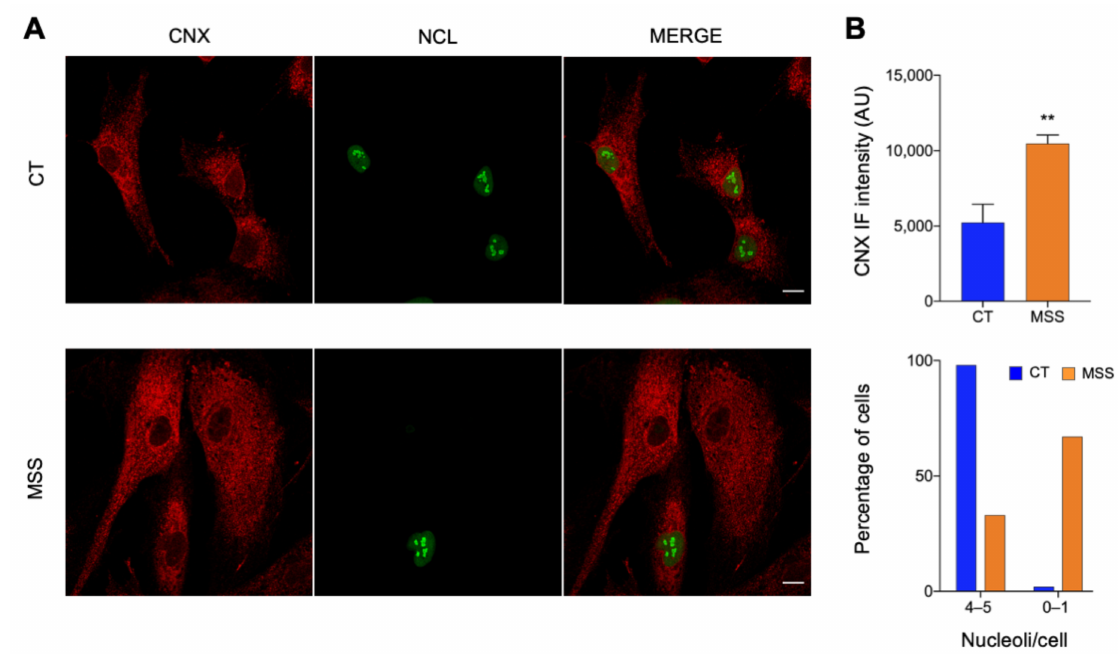
Figure 5. Fluorescence microscopy of representative DE proteins. ( A ) HF-CT (CT) and HF-MSS (MSS) were plated on glass coverslips, fixed in PFA 4%, and processed for immunofluorescence. Confocal images of cells stained for CNX (red) and NCL (green) are shown. The merge of green and red channels is shown in the third panel. Scale bar: 20 µ m. ( B ) Quantification of total CNX staining and the number of NCL-positive nucleoli/cell of the experiment shown in A. Blue and red bars indicate HF-CT and HF-MSS, respectively. ** p < 0.01.